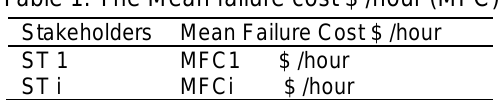
Table 1. The Mean failure cost $ /hour (MFC)